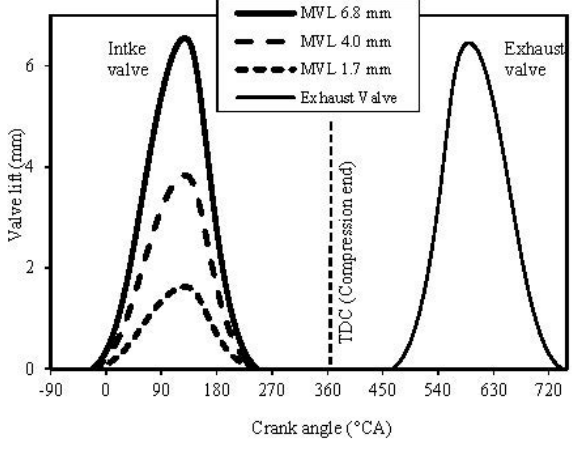
Figure 3. Valve lift profiles of variable valve lift (VVL).